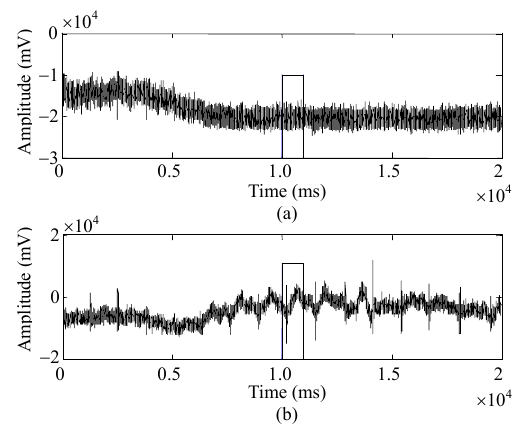
Fig. 2 Intrusion signals: (a) signal I and (b) signal Q.